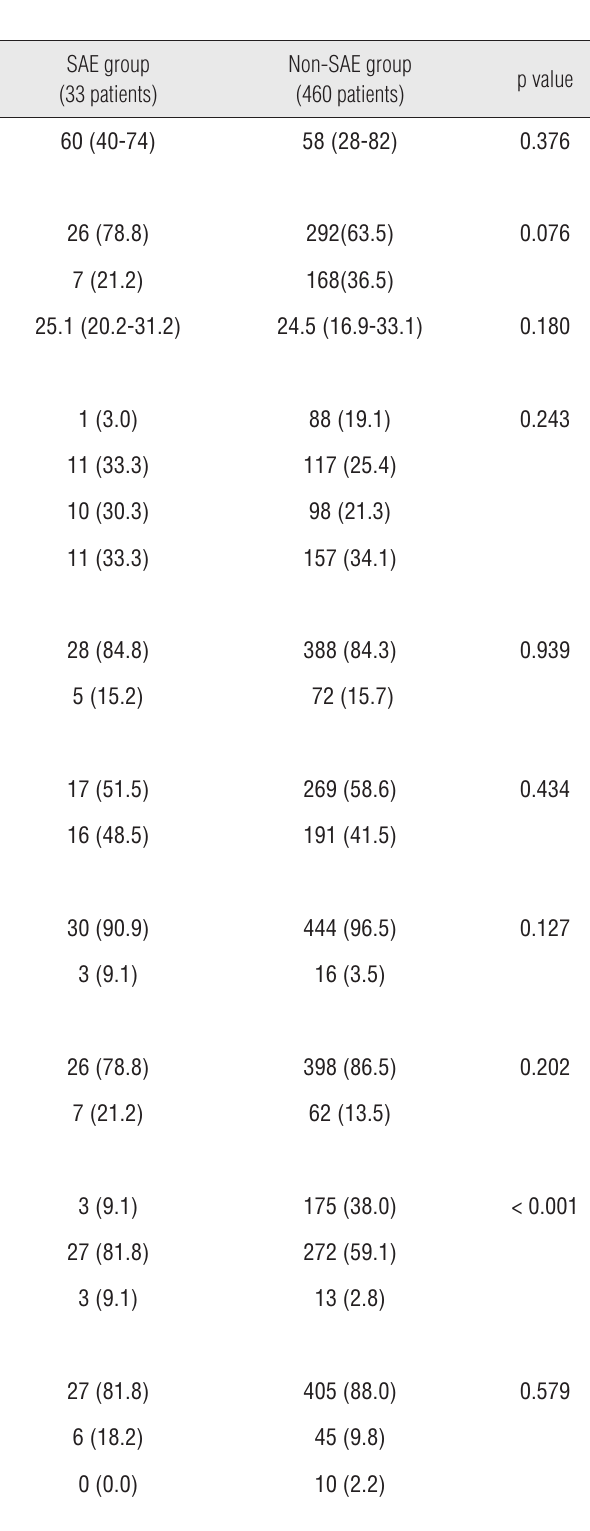
Table 1 - Demographic and clinical characteristics of 493